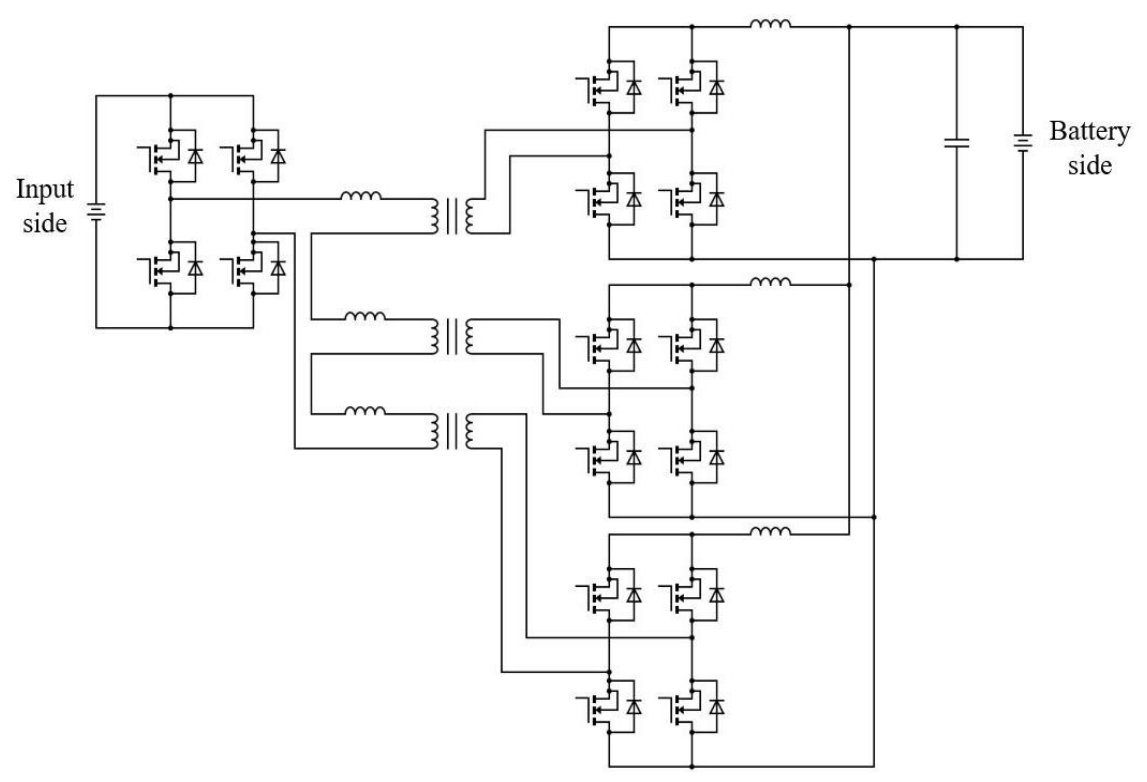
Figure 16. Modular dual active bridge-based charger [63].